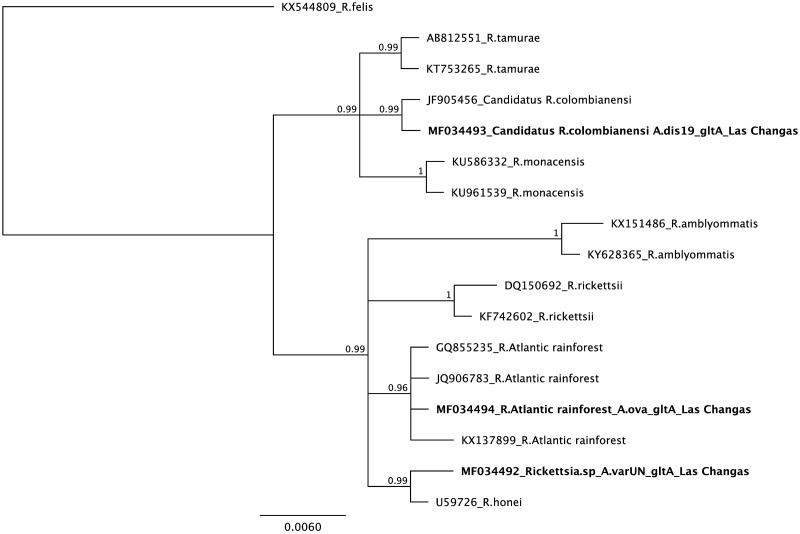
Bayesian phylogenetic analysis of gltA (TPM1uf model).